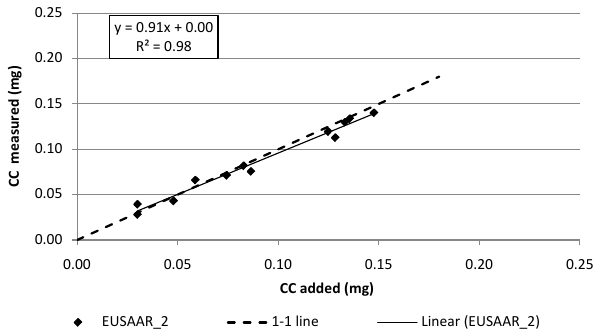
Fig. 3. Regression between CC quantities measured by the EU- SAAR 2 thermal protocol and CC quantities initially added on filter blanks.